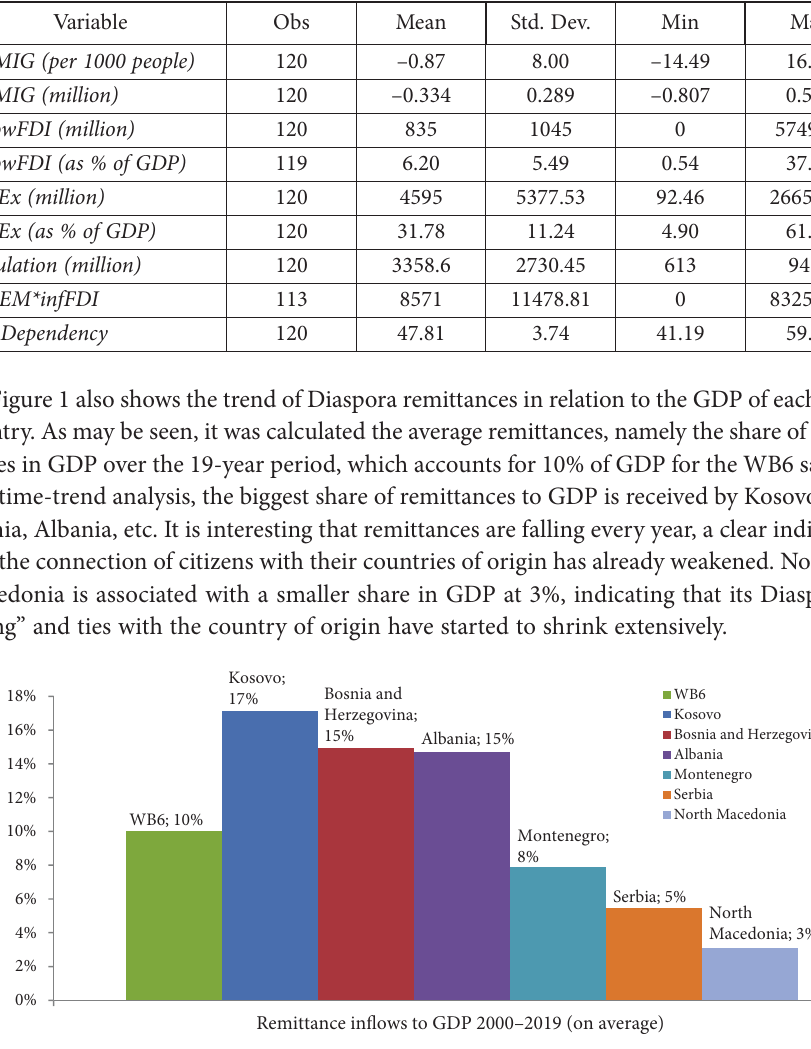
Figure 1. Share of the participation of remittances in the GDP of the WB6